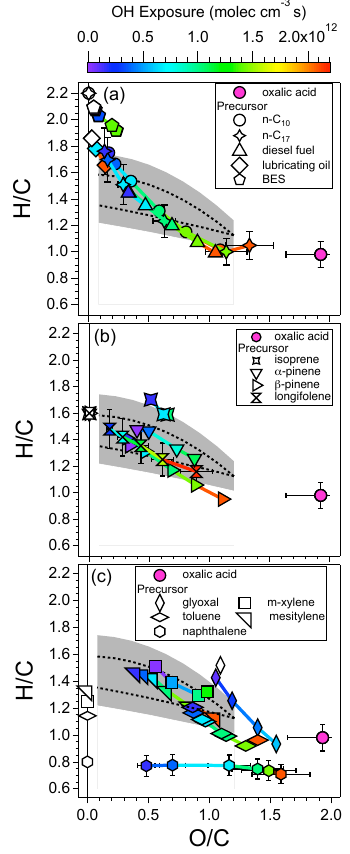
Fig. 6. Van Krevelen diagrams showing H/C ratio as a function of O/C ratio for SOA and OPOA generated in the PAM reactor from (a) alkanes and BES, (b) biogenic terpenoids, and (c) aromatics and glyoxal. Symbols are colored by OH exposure, except for open symbols which represent unoxidized precursors (Note: for n-C 10 , n-C 17 : O/C=0 and H/C=2.2; for isoprene, α -/ β -pinene, longifo- lene: O/C=0 and H/C=1.6). Measured H/C and O/C ratios of at- omized oxalic acid are shown for reference. Representative error bars indicate ± 10 % uncertainty in H/C ratios and ± 15 % uncer- tainty in O/C ratios. Dashed lines represent range of H/C and O/C ratios in ambient OOA converted from corresponding f 43 and f 44 values; shaded grey region indicates conversion uncertainty as de- scribed in Ng et al.